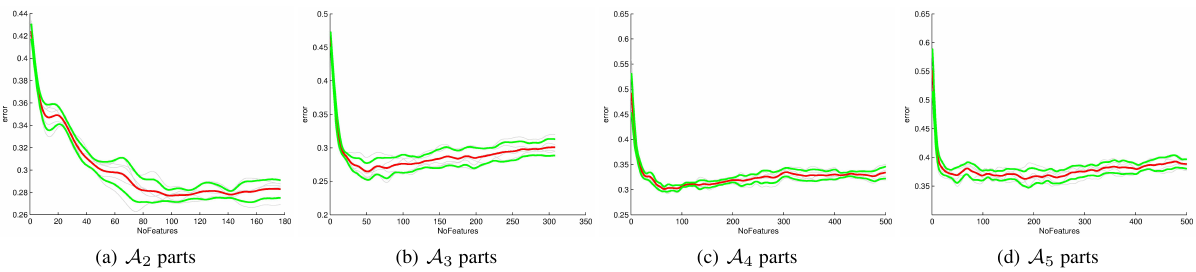
Figure 5: Feature selection, error curves depending on the number of selected features. gray: classification error for different testsets, red: mean error, green: 1 σ